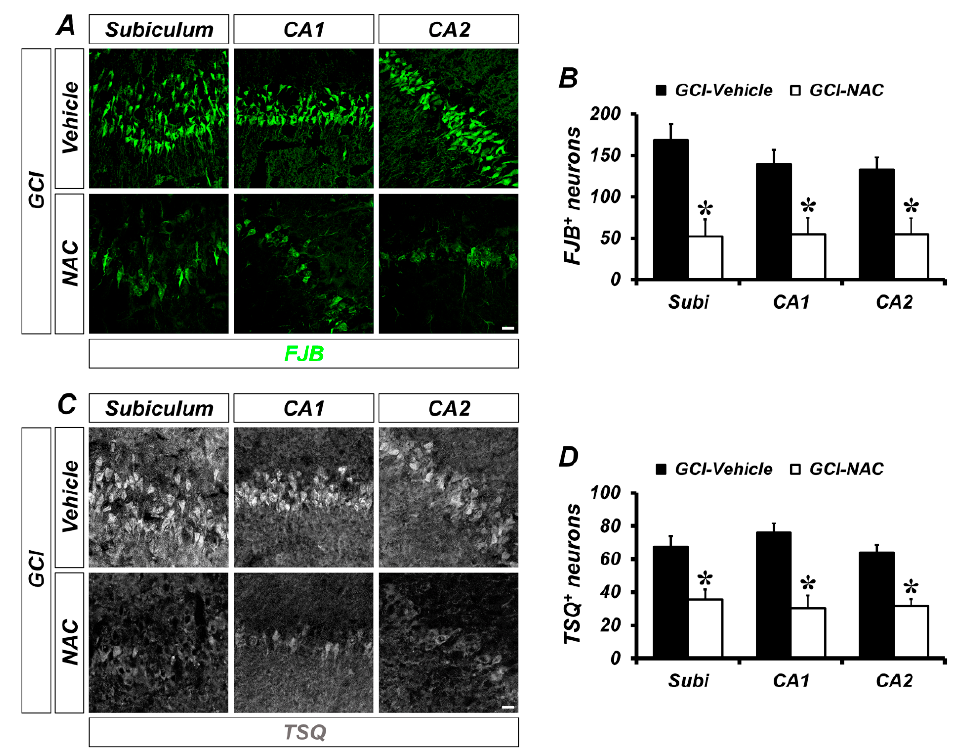
Figure 2. Number of GCI-induced degenerating neurons and zinc accumulation was attenuated by NAC treatment. ( A ) Brain sections were stained with fluorescence dye for detection of degenerating neurons, Fluoro-Jade B (FJB, green signal) in the hippocampal subiculum, cornus ammonis (CA) 1 and CA2 regions. Brain tissues that suffered GCI condition have numerous degenerating neurons in hippocampal regions and administration of NAC reduces the number of FJB-positive neurons in the same regions. Scale bar = 20 µ m. ( B ) Quantification of FJB-positive neurons counted in each hippocampal region. Data are mean ± standard error of mean (SEM), n = 6 each group, * p < 0.05 versus vehicle-treated group (Mann–Whitney U test, Subiculum: z = 2.562, p = 0.010; CA1: z = 2.402, p = 0.016; CA2: z = 2.082, p = 0.037). ( C ) Fluorescence microscopic images of free zinc stained by N -(6-methoxy-8-quinolyl)-para-toluenesulfonamide (TSQ) staining. Bright blue fluorescence signal means ischemic condition-induced excessive zinc release and translocation into hippocampal neurons. The NAC-administered group had a remarkably reduced number of TSQ-positive neurons. Scale bar = 20 µ m. ( D ) Quantification of TSQ fluorescence signal-positive neurons counted from the hippocampus. Data are mean ± SEM, n = 4–5 each group, * p < 0.05 versus vehicle-treated group (Mann–Whitney U test, Subiculum: z = 2.205, p = 0.027; CA1: z = 2.449, p = 0.014; CA2: z = 2.449, p = 0.014).